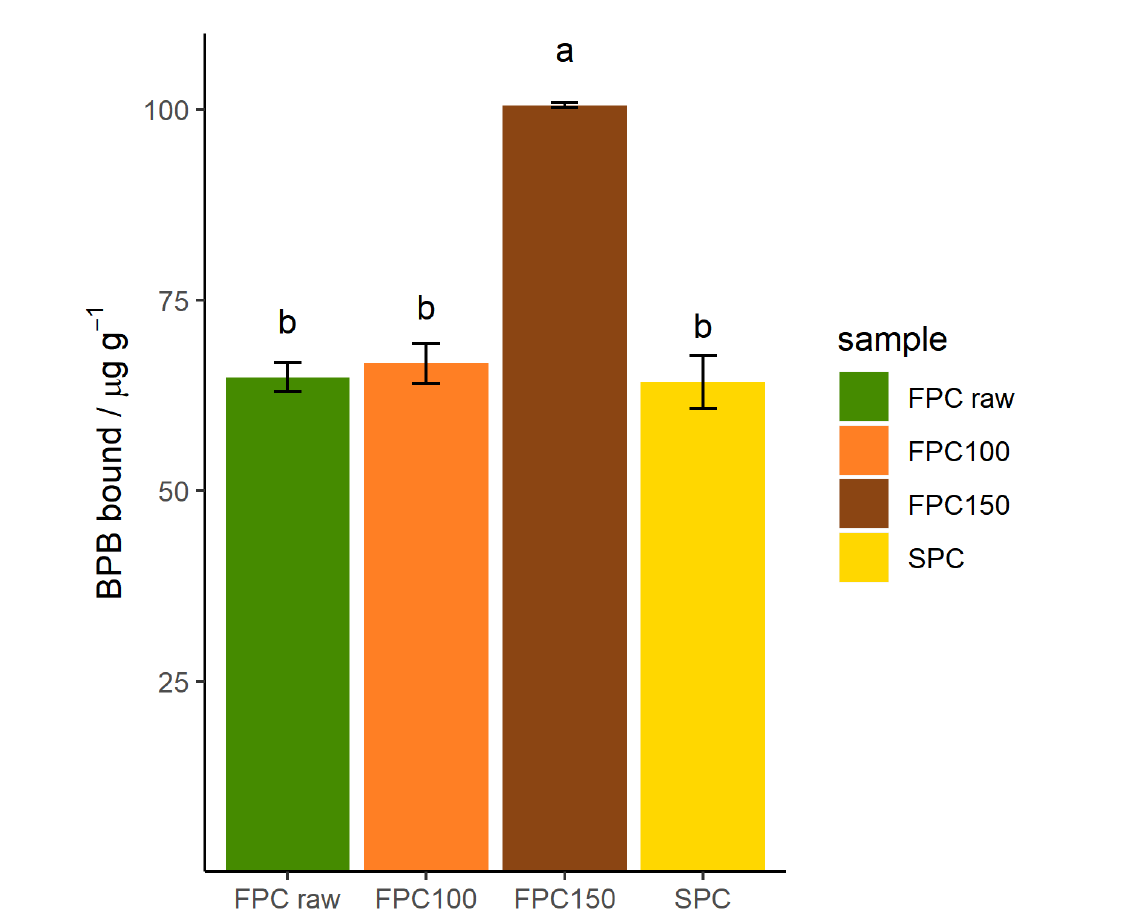
Figure 7. Hydrophobicity as determined by amount of bromophenol blue (BPB) bound to insoluble particles of dry-heated and non-dry-heated FPC as well as commercial SPC. n = 3. FPC dry-heated at 150 ◦ C bound more BPB than all other